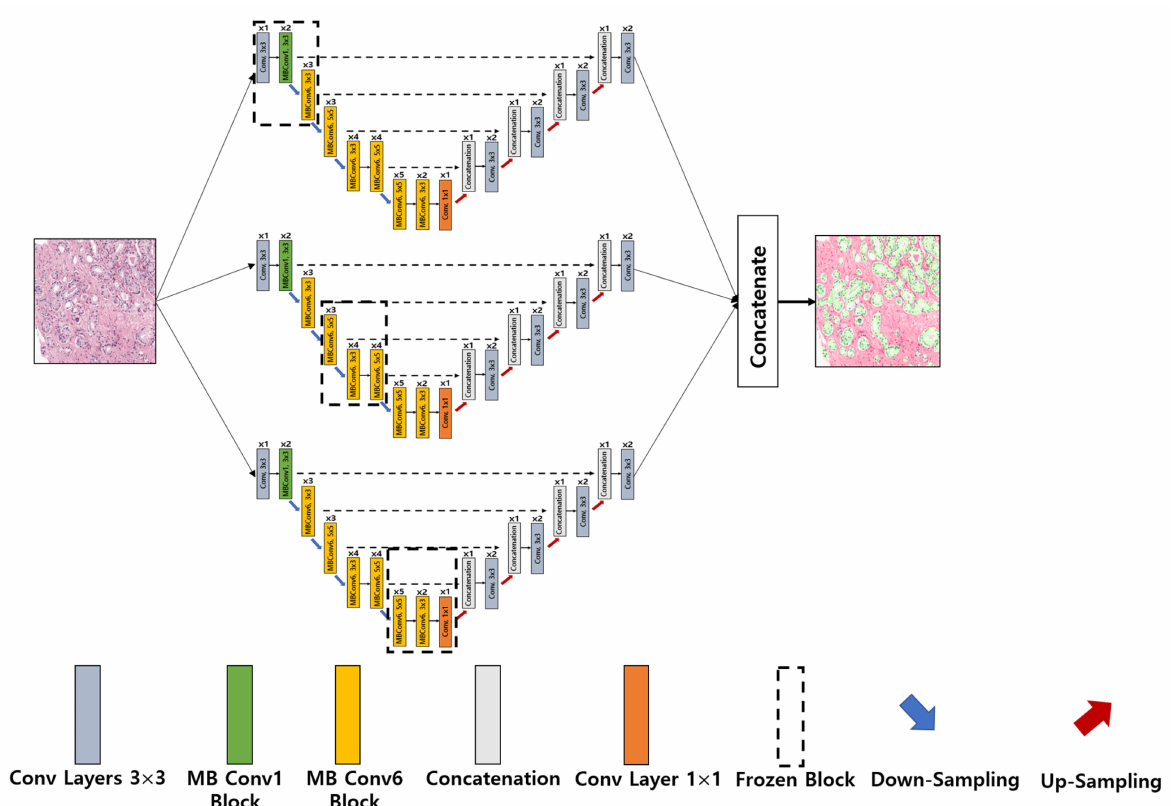
Figure 6. Implementation of the proposed ensemble-based segmentation model. Conv: convolution; MB Conv: mobile inverted bottleneck